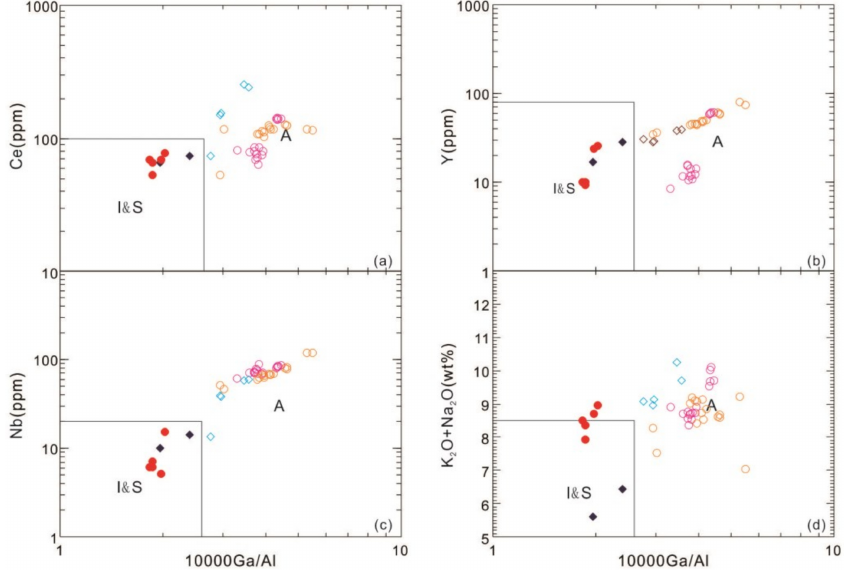
Figure 10. Ce ( a ), Y ( b ), Nb ( c ), and (K 2 O + Na 2 O) ( d ) vs. 10,000Ga/Al discrimination diagrams for the Keri rhyolite in the EKOB (after Whalen et al. [84]). A=A-type granitoids; I=I-type granitoids; S=S-type